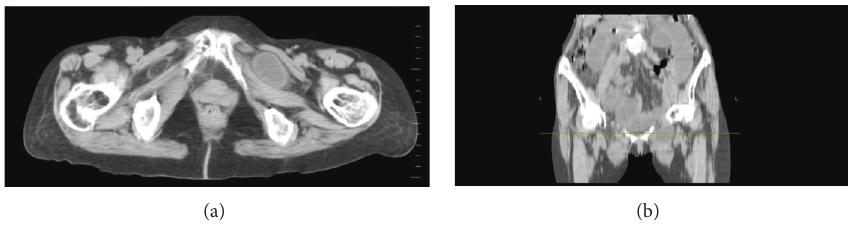
Figure 4: (a) Plain CT scan of inguinal and upper thigh region showing herniated small bowel loop in left obturator canal between pectineus and obturator externus muscles and herniation of mesentery in right obturator canal. (b) Coronal reformatted image at level of obturator canal showing herniated small bowel loop in left obturator canal and herniation of mesentery in right obturator